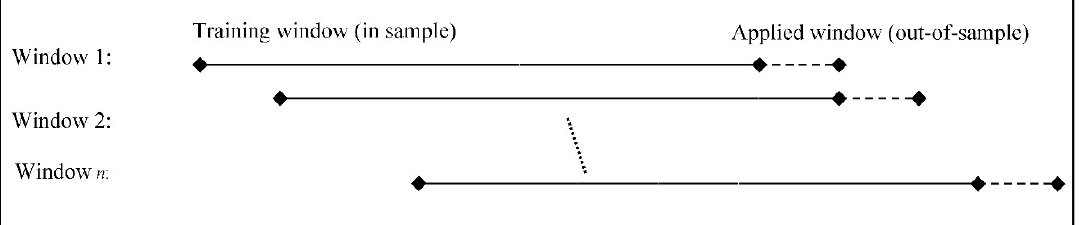
Figure 9. Illustration of one set composed of n rolling windows. The dashed lines represent the applied windows.